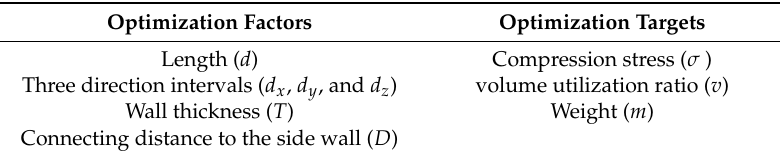
Table 1. Optimization factors and targets for the storage tank.